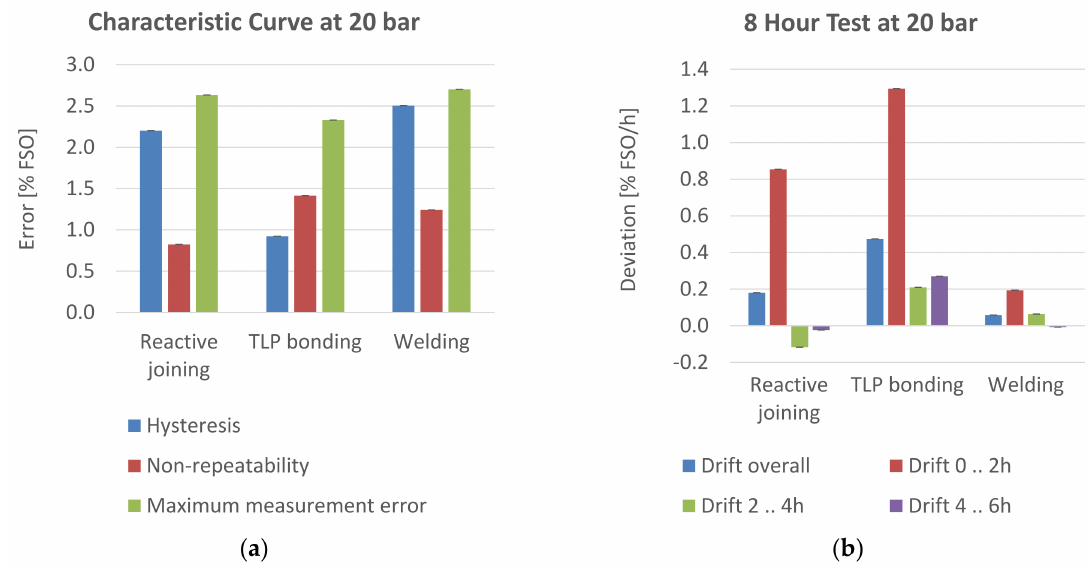
Figure 15. Characterization at 20 bar overpressure; ( a ) characteristic curve; ( b ) drift